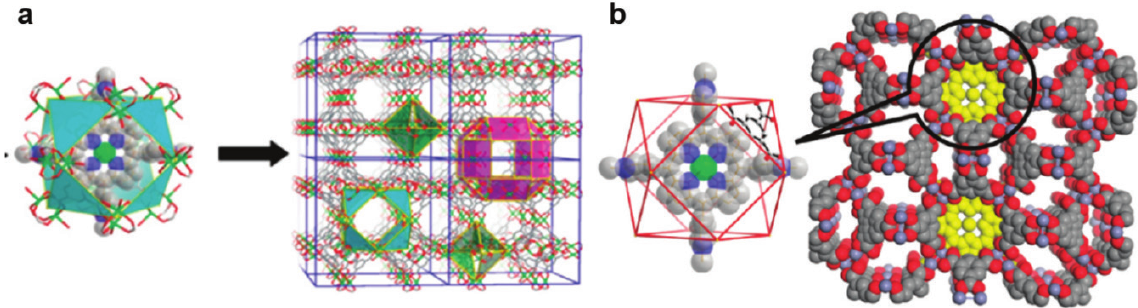
Figure 10 : (a) TMPyP encapsulated in the octahemioctahedral cage of the HKUST-1 framework with pyridyl rings extending into adjacent cages (left) and the polyhedral cage framework of porph@MOF-4, -5, and -6 with three distinct cages (right); (b) TMPyP located in an octahemioctahedral cage of porph@MOF-9 (left) and space-fill model of porph@MOF-9 projected along the c-axis showing the novel 3,3,4,4,6-connected net [112]. Reprinted with permission from Ref. [112]. Copyright © 2012, American Chemical Society.